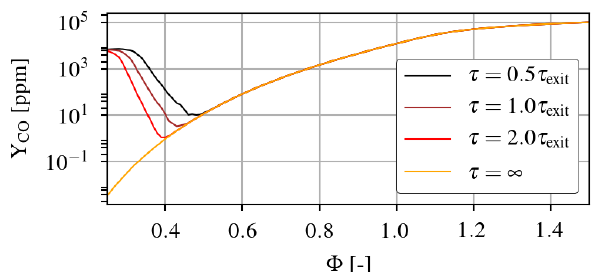
Figure 4. Carbon monoxide (CO) mass fractions over equivalence ratio in dependency of the system (cid:82) x dx residence time τ = from 1D flames. The CO peak value marks τ = 0 and τ exit is the x | τ 0 u ( x ) volumetric combustor residence